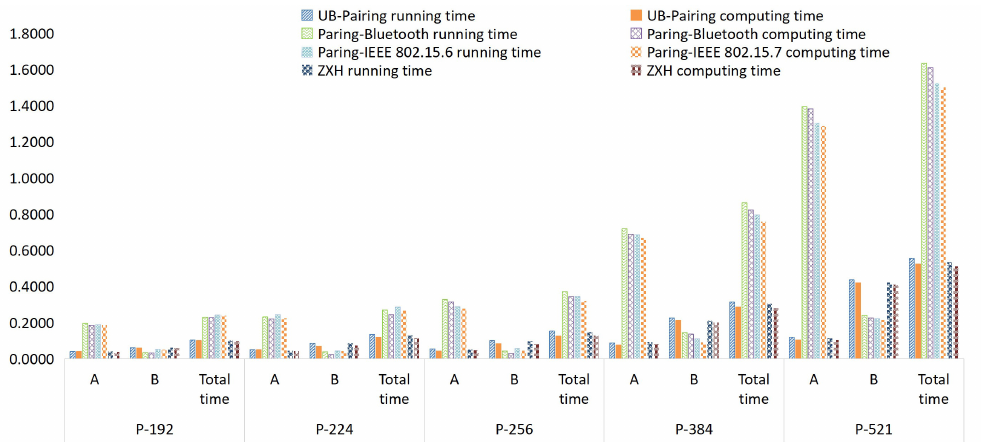
Figure 6. Average protocol running and computing time of UB-Pairing and benchmark protocols on Raspberry Pi and virtual machine in experiment